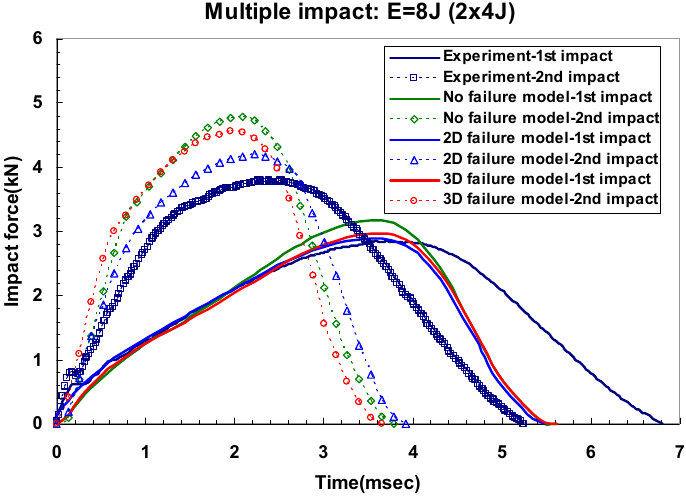
Figure 16. Multiple impact force-time curves. Comparison of experimental and simulation results for GLARE 5-2/1 under impact energy of 8 J. Table 7. Difference between predicted and measured peak impact force for GLARE 5-2/1. Differences of Peak Impact Force Impact Energy